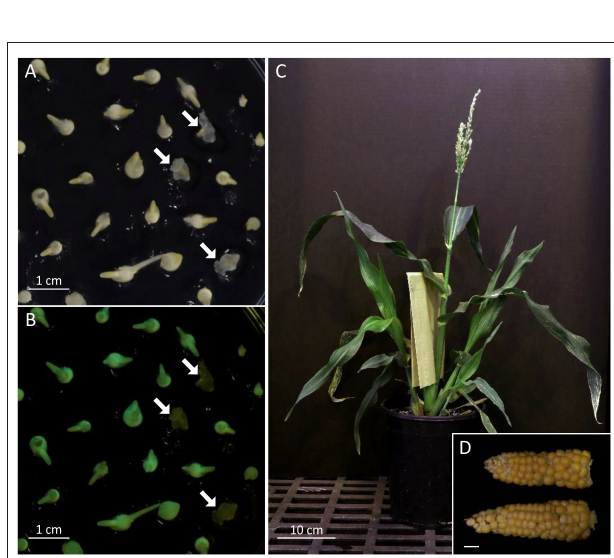
FIGURE 4 | FFMM-AT. Screening of haploid embryos under bright field (A) and NIGHTSEA flashlight with GFP filter glasses (B) . White arrows point to non-GFP-expressing haploid embryos. (C) A mature FFMM-AT plant; (D) Mature ears of AT6R; bar scale, 1cm.